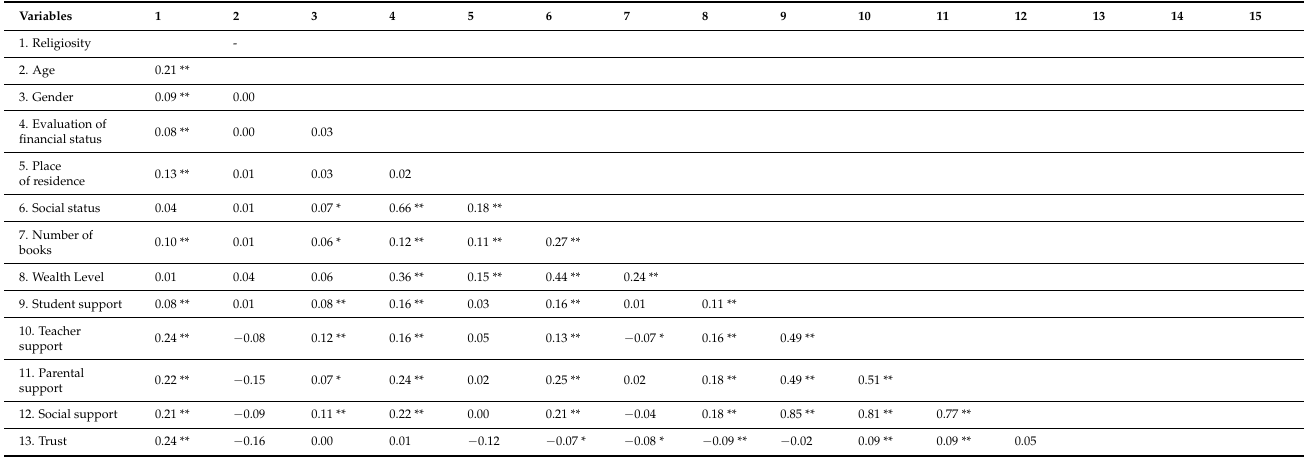
Table 3. Correlation coefficients among all predictors